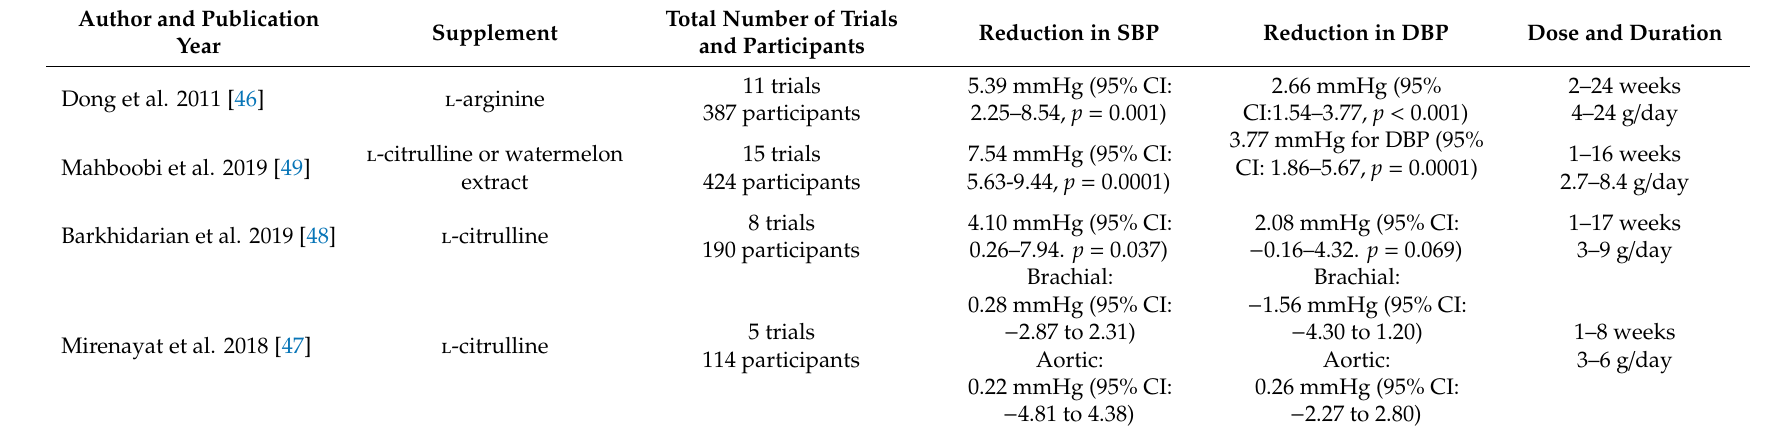
Table 3. Summary of the results of meta-analysis investigating the e ff ects of oral l -citrulline and l -arginine supplementation on blood